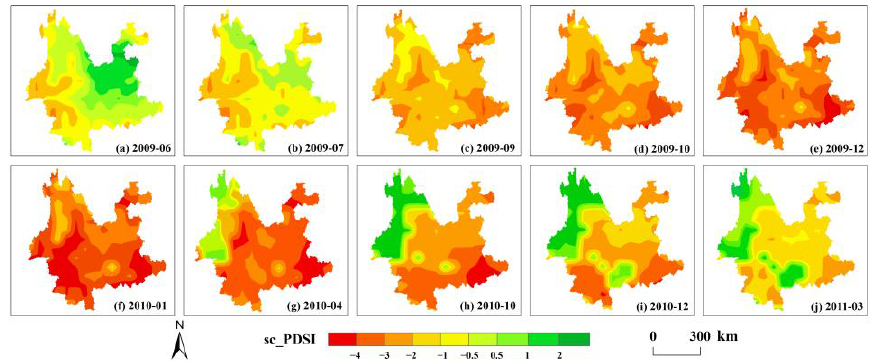
Figure 9. Spatial distribution of monthly average values of sc_PDSI from 2009 to 2011. Table 2. Percentage of drought extent in 2009 – 2010 (according to sc_PDSI classification criteria).